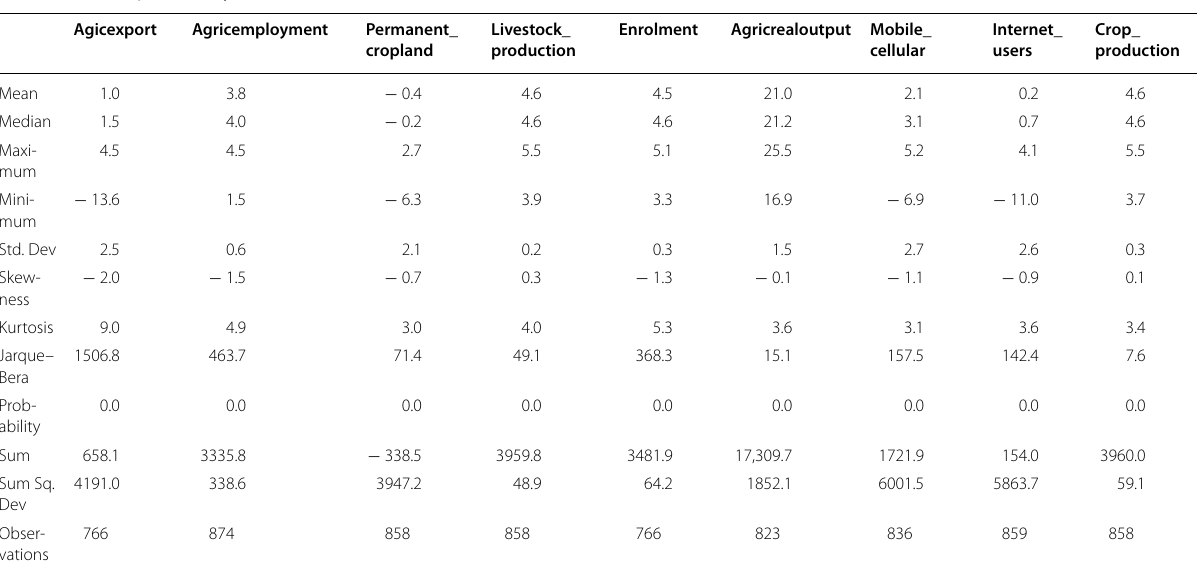
Table 1 Descriptive analysis of